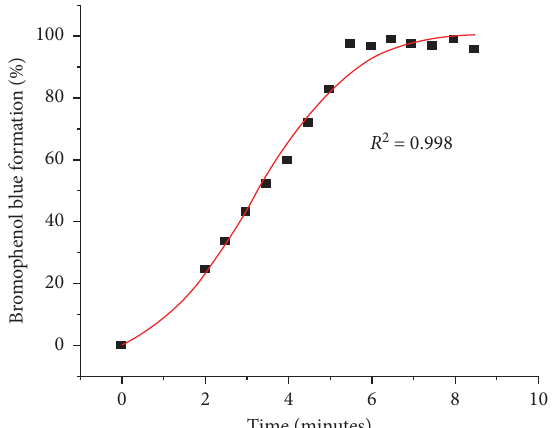
Figure 20: Bromination of phenol red to bromophenol blue using Fe 3 O 4 @SiO 2 @LEuH@PW 10 as a POM nanocomposite catalyst. The reaction was monitored at time intervals of 30 seconds (1 � 0s, 2 � 30s, ... , 12 � 330s). Reaction conditions are as follows: 10ml of 1.0mM phenol red in water+ 10ml of 10.0mM NH 4 Br in water+0.5 g of catalyst +2.5mM · H 2 O 2 , in a round-bottomed flask. T � 298K and P � 1atm.